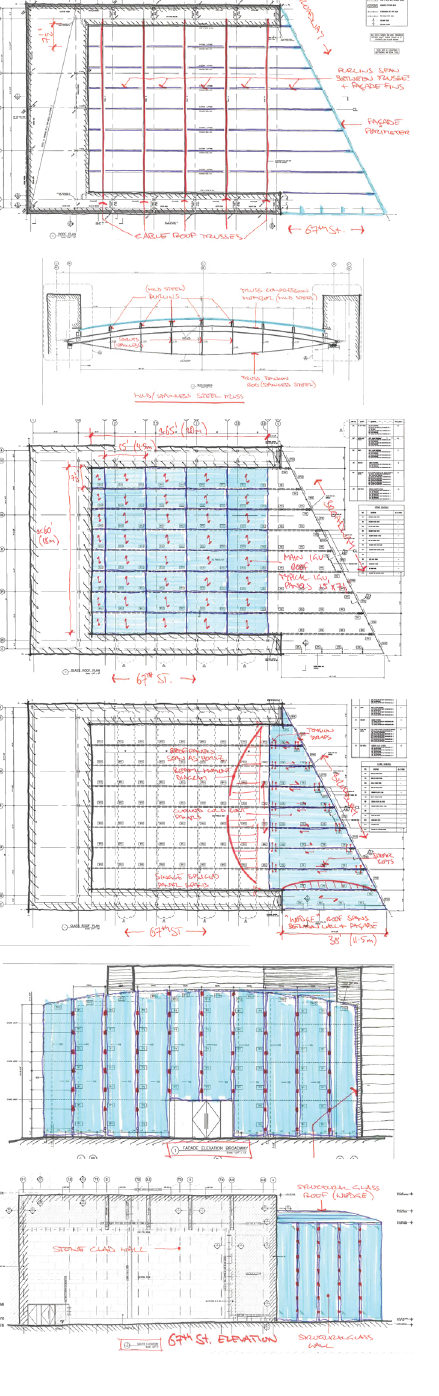
Figure 7: 67 th St. elevation. The 5 panels on this elevation are spliced together to act as a single shear wall resting in-plane